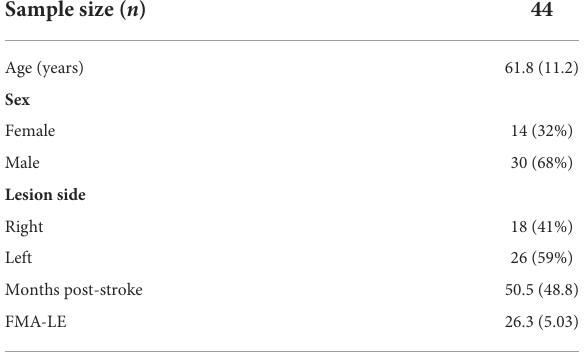
TABLE 1 Summary data for stroke participant